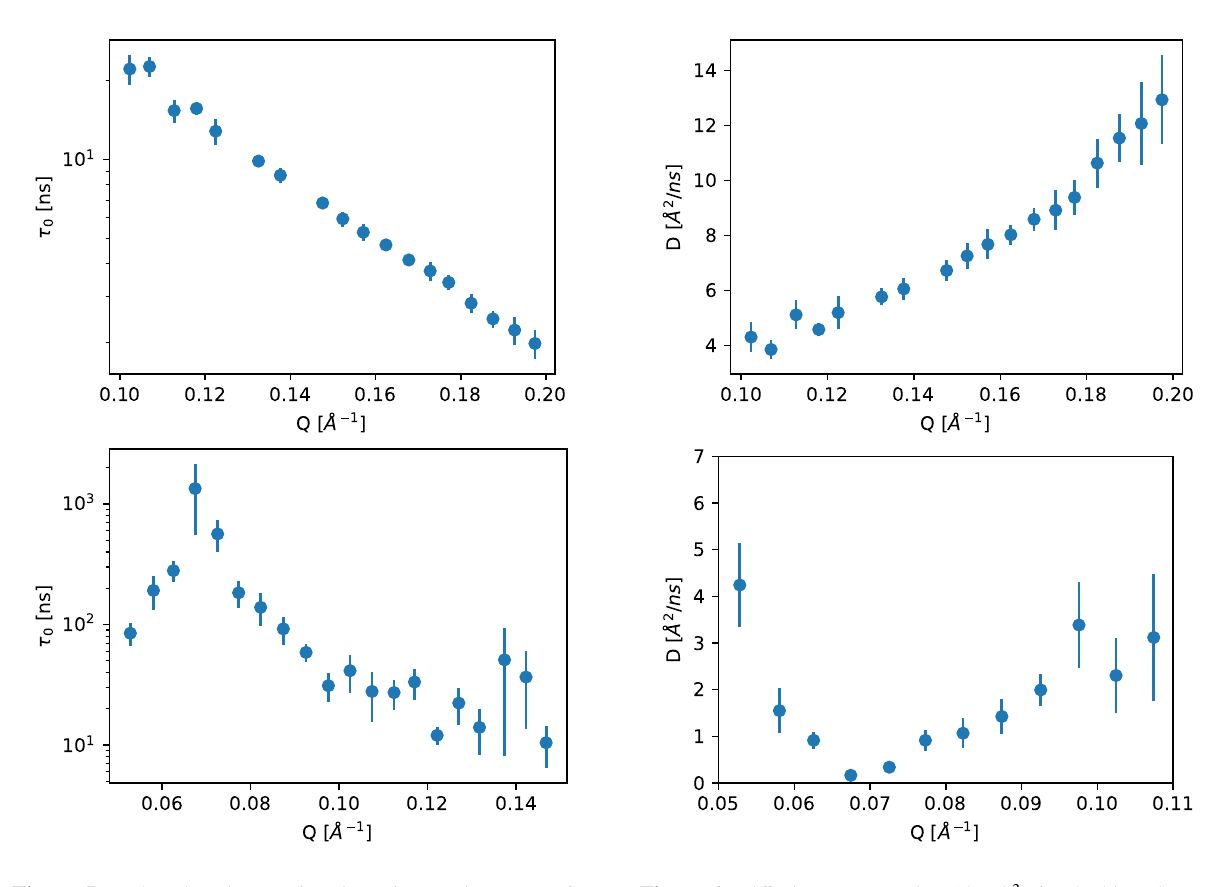
Figure 5. Relaxation time as function of scattering vector for the bicontinuous microemulsion (top) and the ordered lamellar microemulsion (bottom).